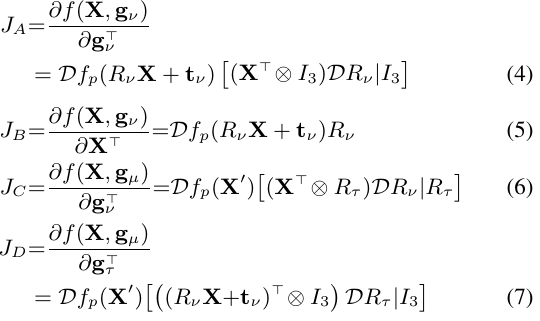
Figure 2. Primary structure of the BBA Jacobian for a block of 2 nadiral cameras, 8 oblique and 3 points